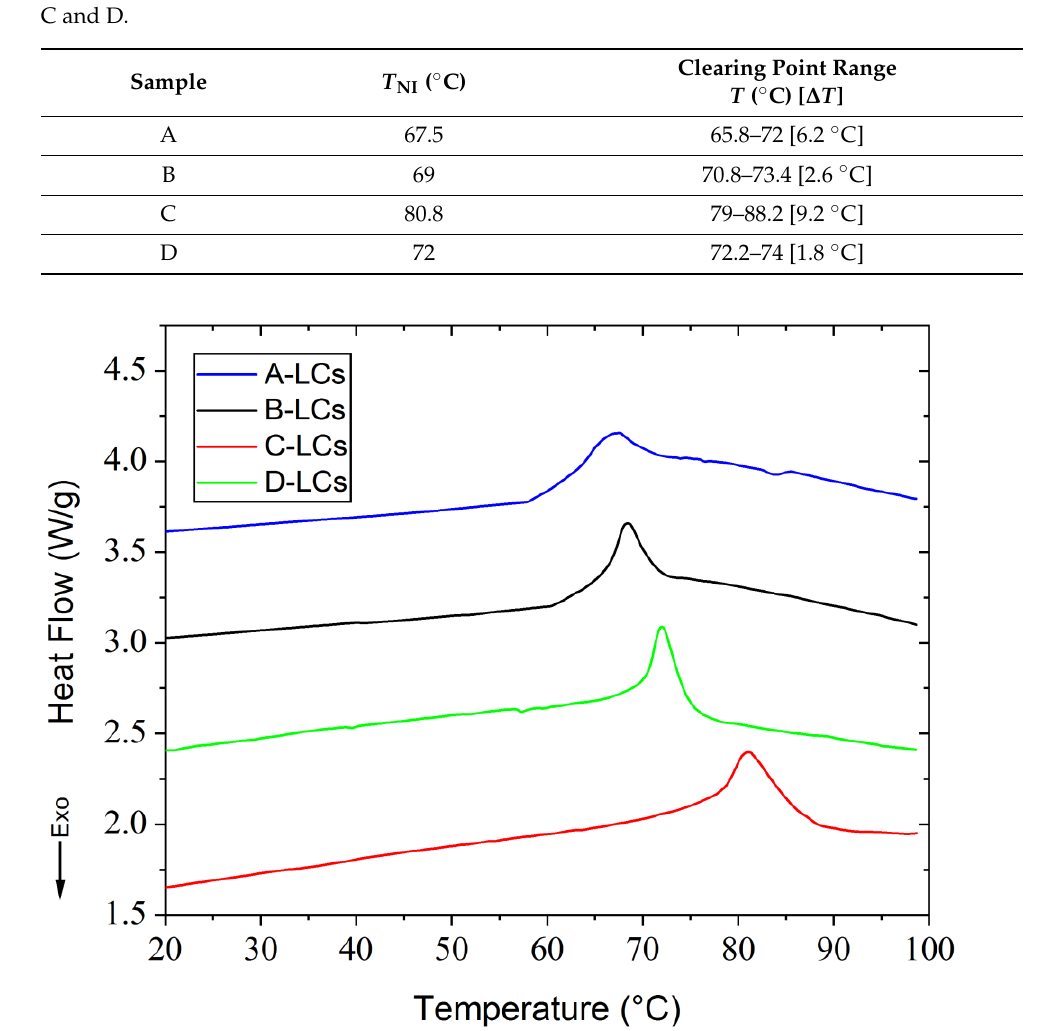
Figure 8. DSC results from LC mixtures of EOL-LCDs A, B, C and D.